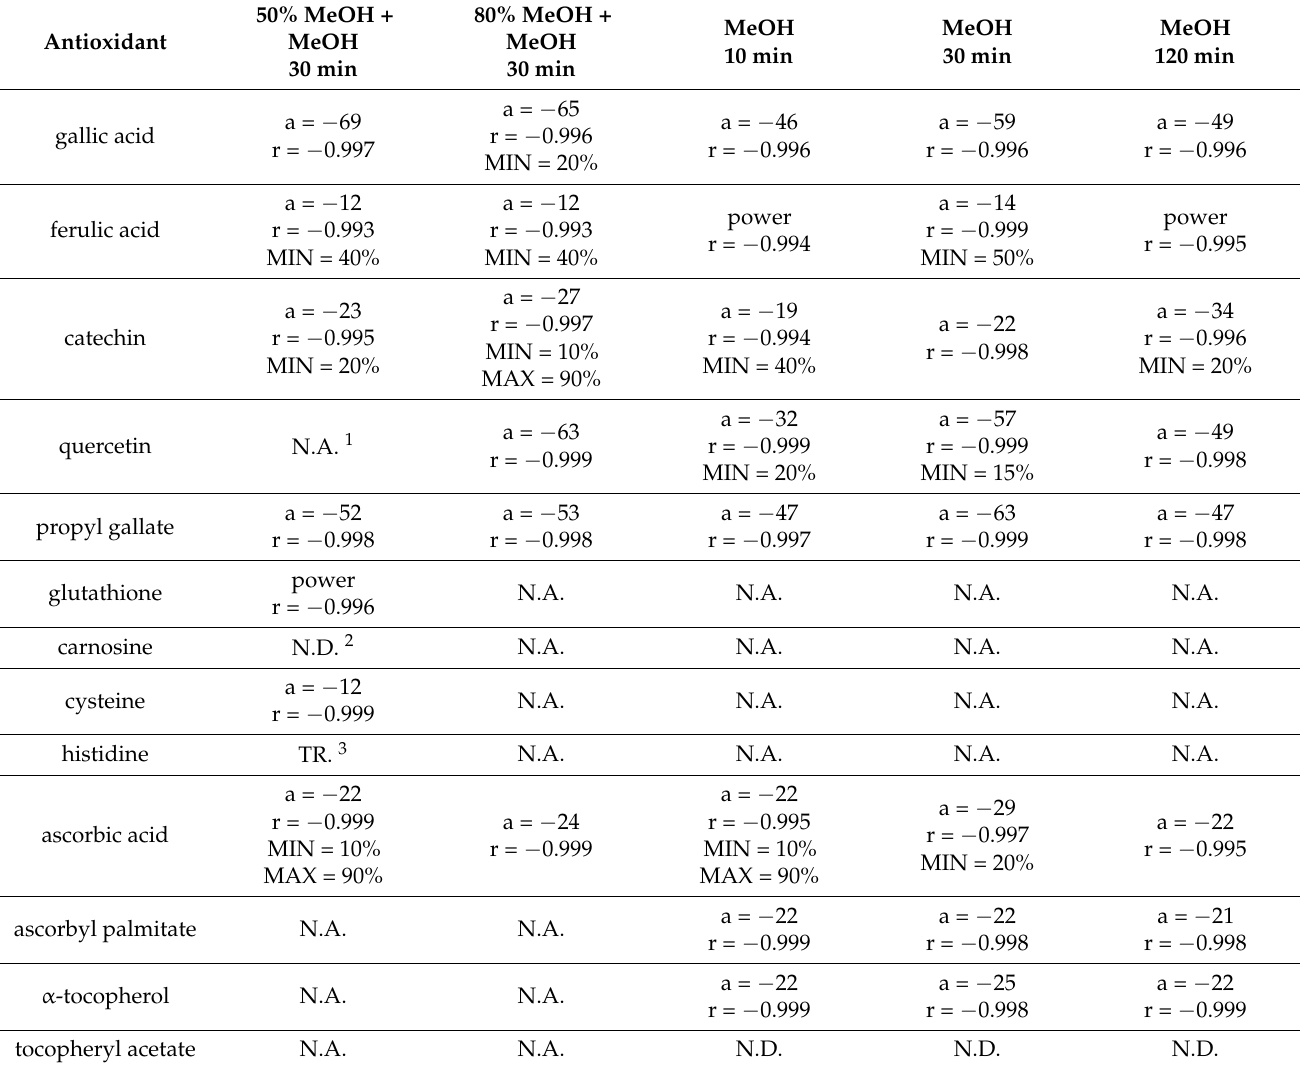
Table 3. Linear and non-linear relations obtained for different antioxidant concentrations ( µ M) applied against DPPH radicals in methanol or aqueous methanol after standard and modified reaction times (radical solution in methanol). In case of linear relations, slope (a), correlation coefficient (r) and lower/upper linearity limits if occurring (MIN/MAX–as % of A contr ) were shown; in case of a non-linear relationship, equation type and correlation coefficient were